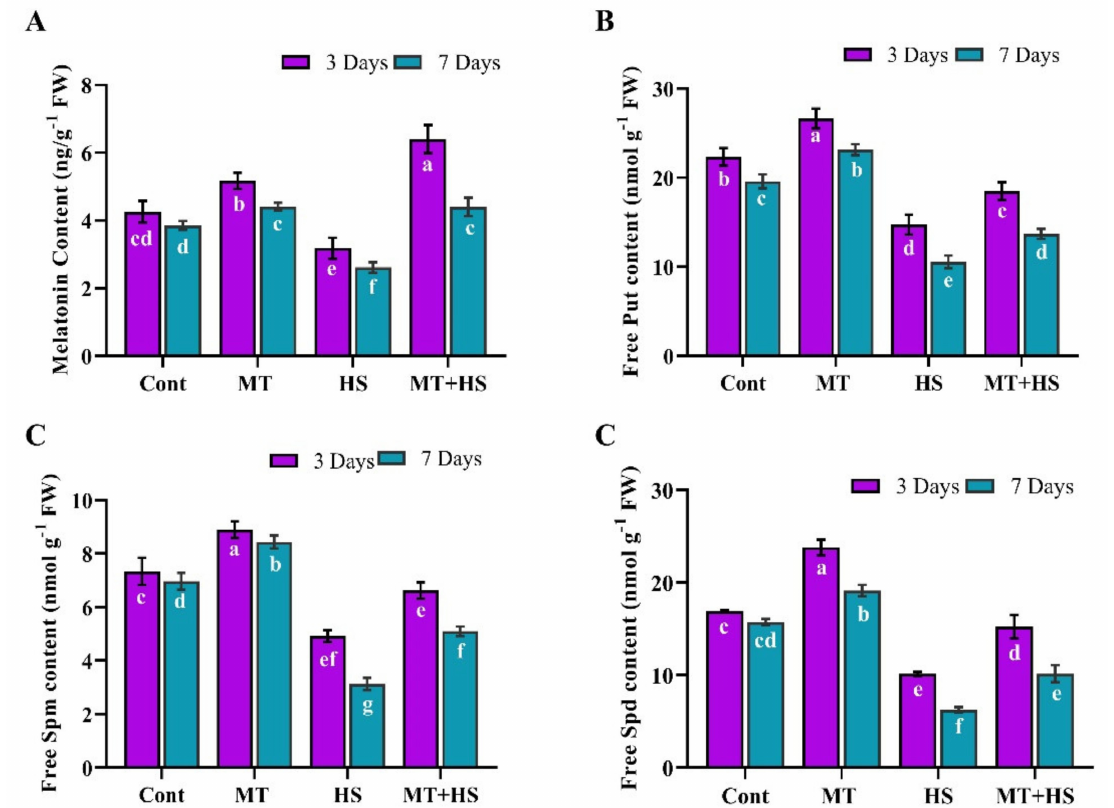
Figure 5. Effects of melatonin application with or without high temperature (42 ◦ C) on ( A ) endogenous melatonin content, ( B ) polyamine putrescine, ( C ) spermine, and ( D ) spermidine in soybean seedling after 3 and 7 days. Each data point is the mean of three replicates. Error bars represent the standard error of the mean. Bars with different letters are significantly different from each other by Duncan’s multiple range test at p ≤